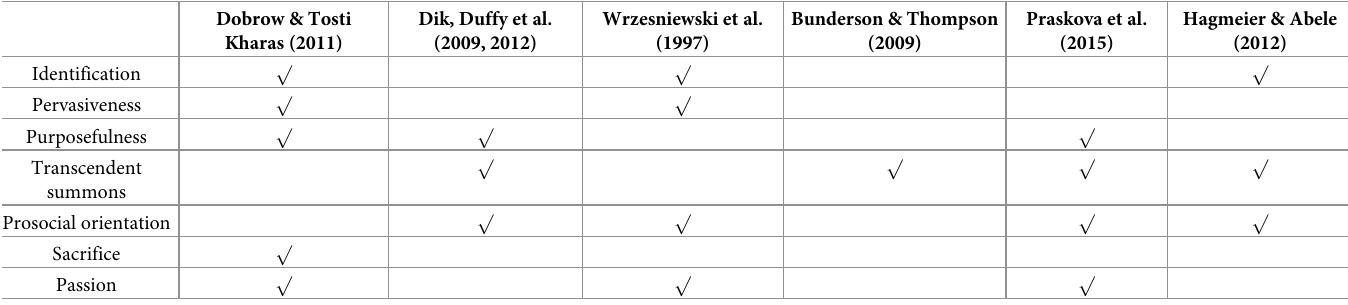
Table 1. Dimensions of calling across six different theoretical